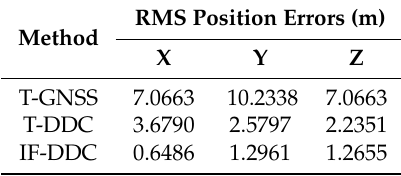
Table 7. RMS position error statistics of the dynamic test.